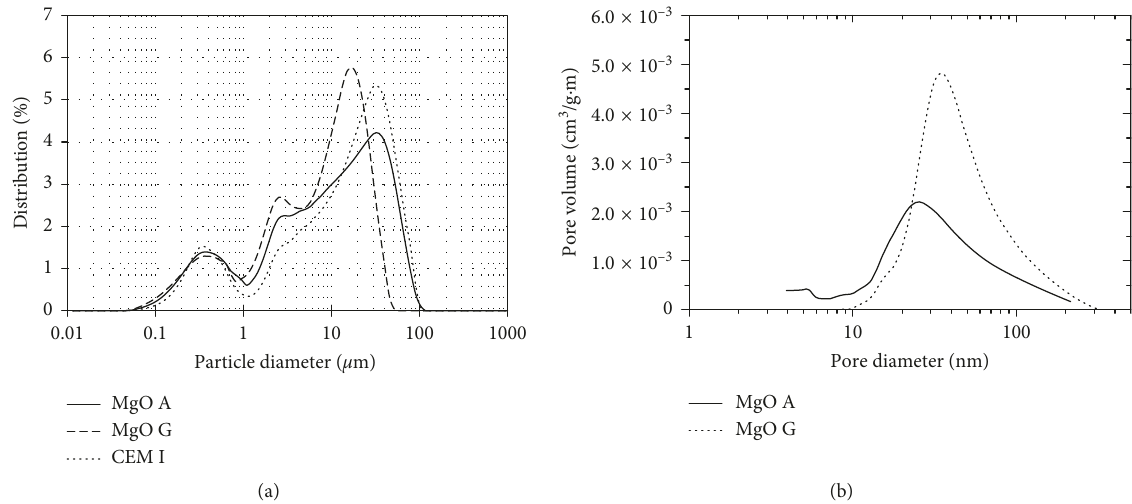
Figure 2: Particle-size distributions by using laser diffraction (a) and pore volume (b) of MgO A, MgO G, and